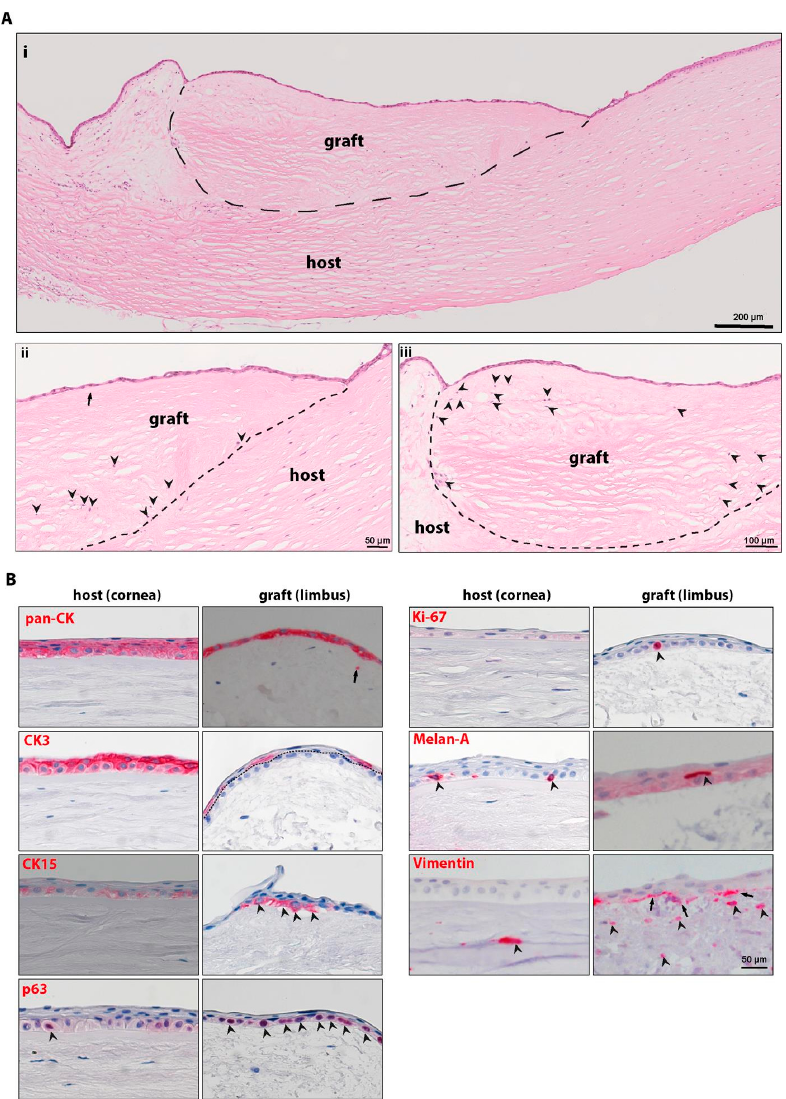
Figure 5. Ex vivo transplantation of decellularized human limbus (DHL). ( A ) Three weeks after transplantation, histological analyses by hematoxylin and eosin (H&E) staining show complete epithelialization of graft tissue with stratification ( i ); graft with Bowman’s layer (arrow, ii ) and the presence of stromal cells in the graft tissue (arrowheads, ii and iii ). Dashed line marks the boundary between the graft and host tissue. ( B ) Immunohistochemical staining of paraffin sections showing the cytokeratin (pan-CK) expression on epithelial cells; CK3 expression in all epithelial cells of the host, whereas only suprabasal cells in the graft (dotted line separates the basal and superficial cells); p63 + cells in the graft and host tissue (arrowheads), and Ki-67 + cells at basal layers of epithelial cells of the graft tissue (arrowheads); Melan-A expression (magenta, arrowheads) in melanocytes at basal layers of epithelium in both host and graft tissue, and vimentin expression in the basal cells of the epithelium (graft tissue, arrow) and stromal region (arrowheads) in both host and graft tissue. Abbreviations: pan-CK, pan-cytokeratin; CK3, cytokeratin 3; CK15, cytokeratin